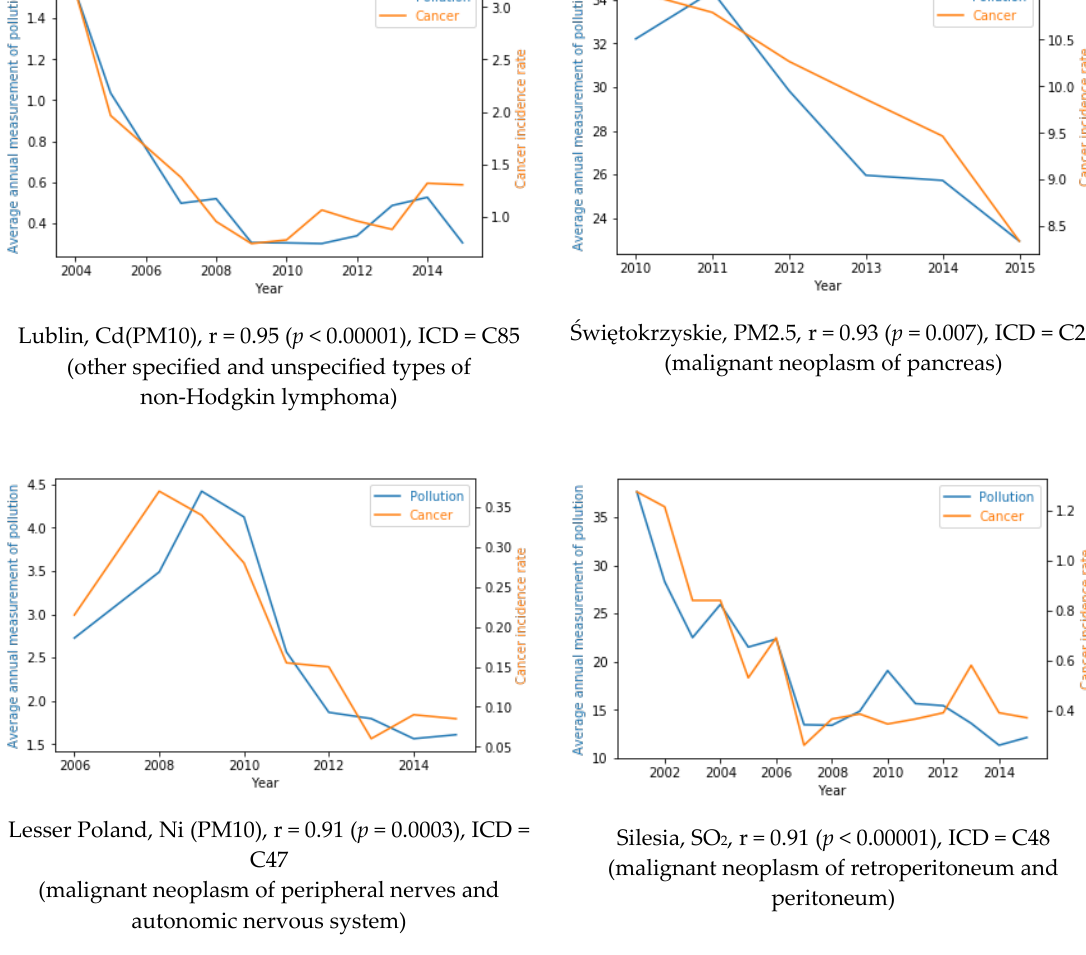
Figure 2. The highest correlations between average air pollution ( µ g / m 3 ) and cancer formation in selected provinces of Poland, where r stands for the Pearson correlation coefficient and ICD is the International Classification of Diseases code of the disease.